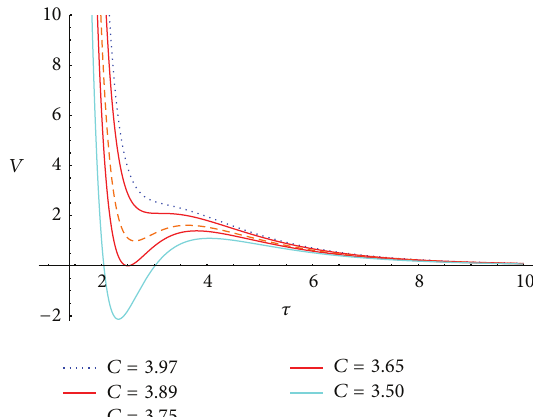
Figure 3: Potential of one modulus model for the K¨ahler uplift. The red curves correspond to the limits on the parameter 𝐶 for a dS vacuum,whilethedottedonecorrespondsto 𝐶 inthedestabilization